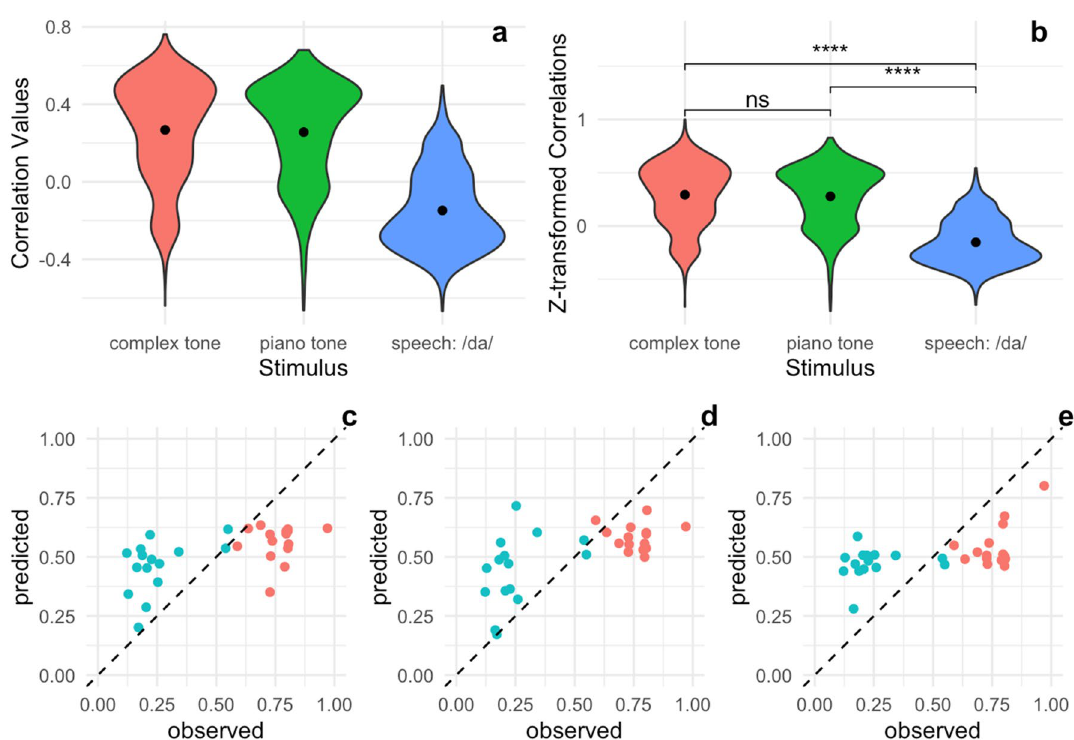
Figure 3. Performance of Lasso Regression Models Using FFR to Different Stimuli as Predictors. ( a , b ) For each model, a correlation between the model’s predictions and true AP sine and piano performance was computed on a test set (data points not seen by the model during training) for each of 1000 cross-validation runs as an estimate of how well the model generalizes. See Eqs. (1–3) for final model specifications. ( c ) Predicted AP sine and piano performance values based on complex tone FFR plotted against actual, observed AP performance. Red dots represent subjects who self-reported as AP possessors. ( d ) Predicted AP performance values based on piano tone FFR plotted against observed AP performance. Red dots represent subjects who self-reported as AP possessors. ( e ) Predicted AP performance values based on speech /da/ FFR plotted against observed AP performance. Red dots represent subjects who self-reported as AP